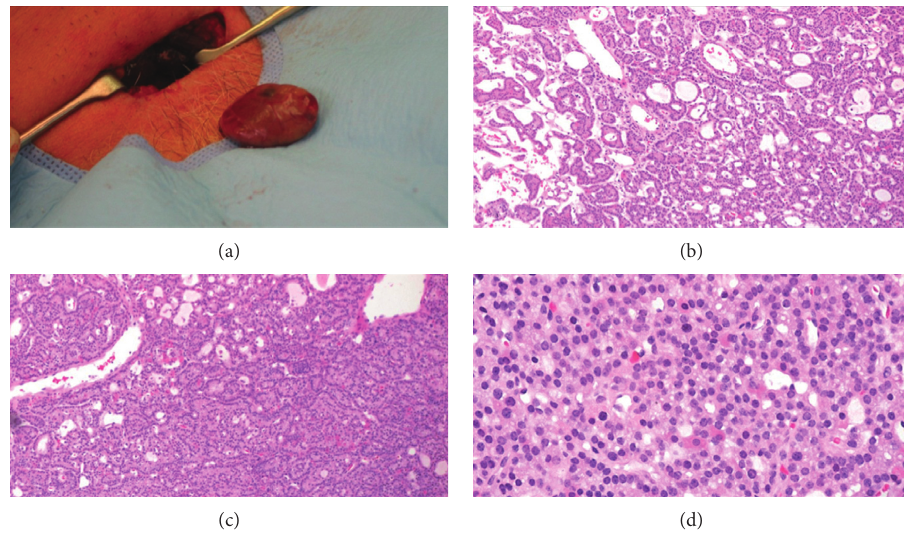
Figure 1: (a) Parathyroid adenoma. Hematoxylin-eosin stain (4x) showed the absence of adipose tissue and follicular (b) and trabecular (c) growth pattern, with a predominance of chief cells and some oxyphilic cells (d).